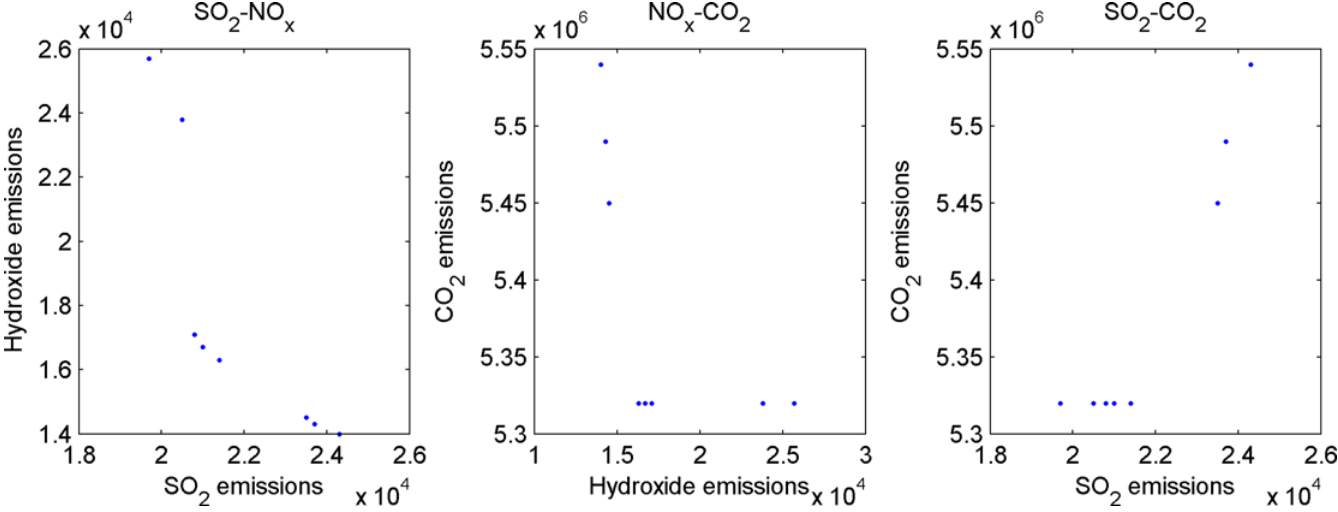
Fig 4. Pairwise comparisons of efficient solutions and target